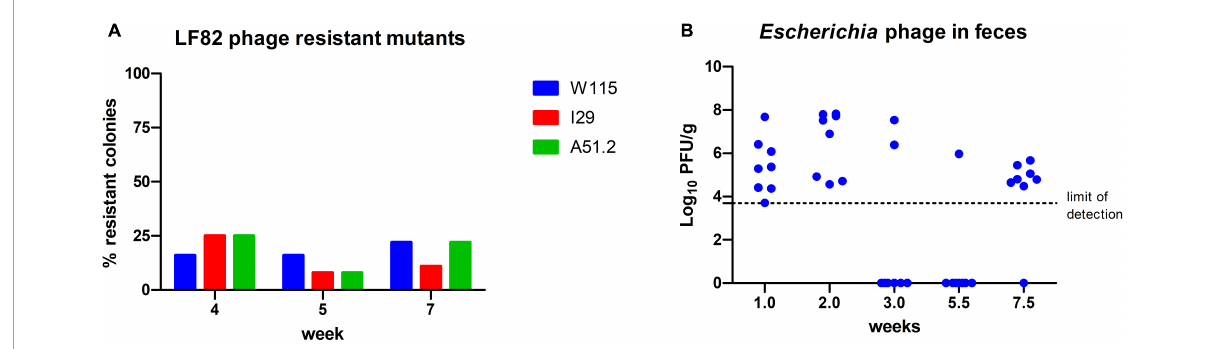
FIGURE7 Enumeration (A) E. coli LF82 phage resistant colonies and (B) viable EE phages among feces at different time points of the viable phage treated